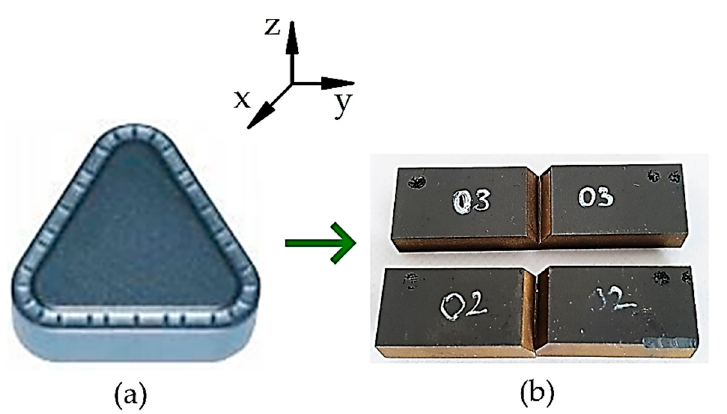
Figure 1. Specimen preparation: ( a ) Cutting plate made of SM25T (TNMR 401060 SM25T) tungsten carbide, produced by Baildonit company; ( b ) real view of specimens used for testing. Geometrical parameters of WC specimen used for testing is presented in Figure 2. Sets of axes indicated in Figures 1 and 2 show the direction towards which the specimens were cut. Each sample had thickness B = 10 mm, width W = 5 mm and notch cut with the length a = 2.5 mm. It should be noticed that the samples were prepared without pre-crack-